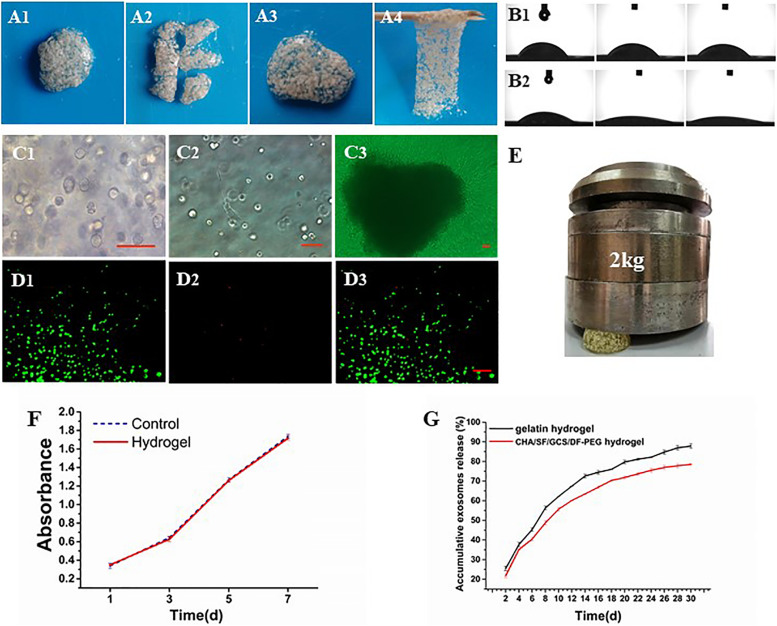
Characterization of the CHA/SF/GCS/DF-PEG hydrogel. (A1–A4) Self-healing evaluation. (B) Contact angle experiment, being (B1) the gelatin hydrogel and (B2) the CHA/SF/GCS/DF-PEG hydrogel. (C) Observation of the growth status of mOPCs in CHA/SF/GCS/DF-PEG hydrogel using an optical microscope (panels (C1–C3) represent the mitotic phase of the cell, the elongation of cells at the bottom of the plate and the release of cells resulting from hydrogel degradation, respectively). (D) LIVE/DEAD staining, (D1) viable cells: green, (D2) dead cells: red, (D3) merge of viable cells and dead cells. (E) Images of the CHA/SF/GCS/DF-PEG hydrogel being compressed by a weight of 2 kg. (F) MTT assay for cytotoxicity evaluation of hydrogel. (G) Release profiles of exosomes from the gelatin hydrogel and CHA/SF/GCS/DF-PEG hydrogels.